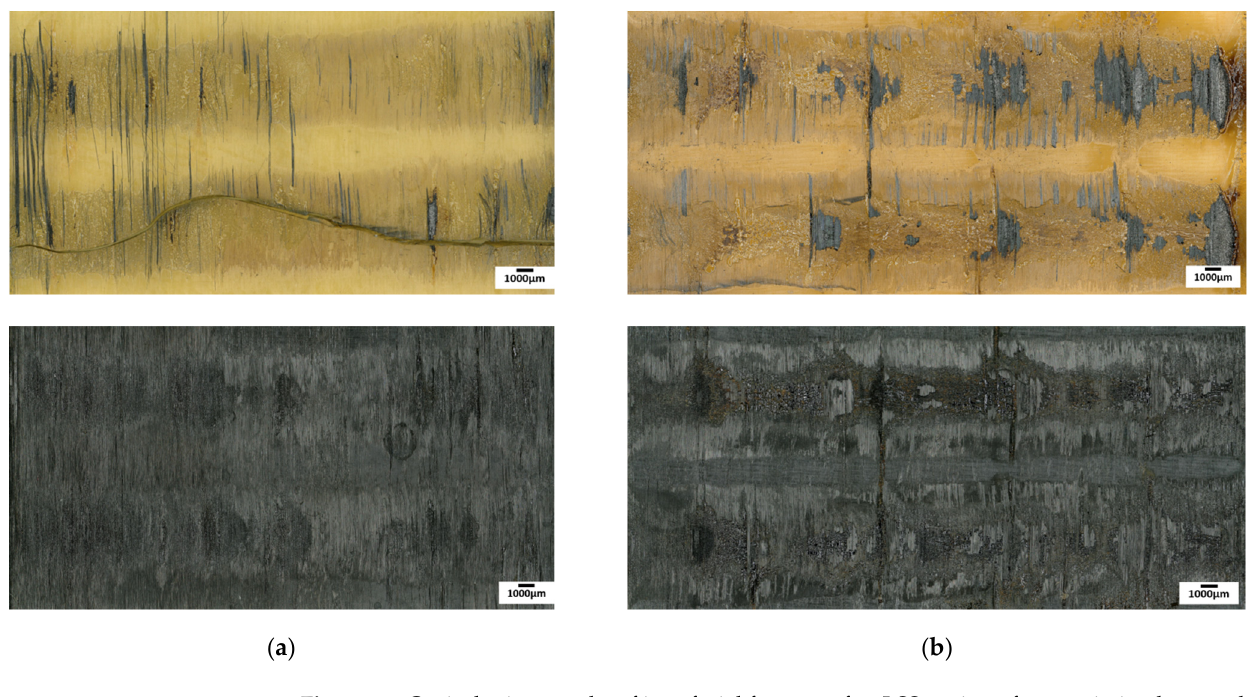
Figure 17. Optical micrographs of interfacial fracture after LSS testing of transmission laser welded of ( a ) 2 mm PEI and ( b ) 4 mm thick PEI on CF/PEEK (on the top, transparent PEI, on the bottom, absorbent CF/PEEK).